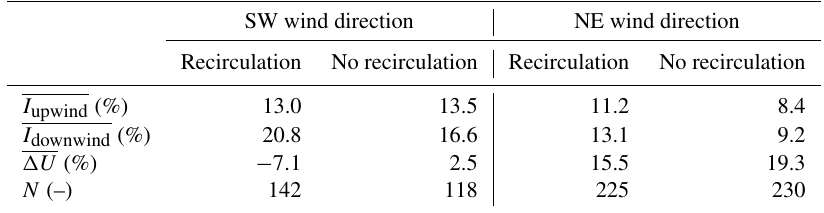
Table 4. Changes in the wind characteristics at the downwind